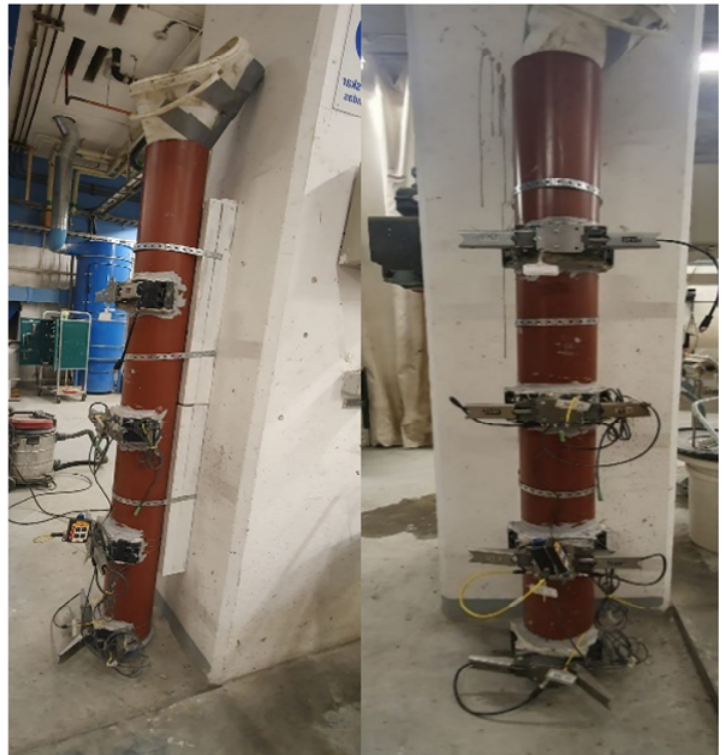
Figure 1. Laboratory setup.